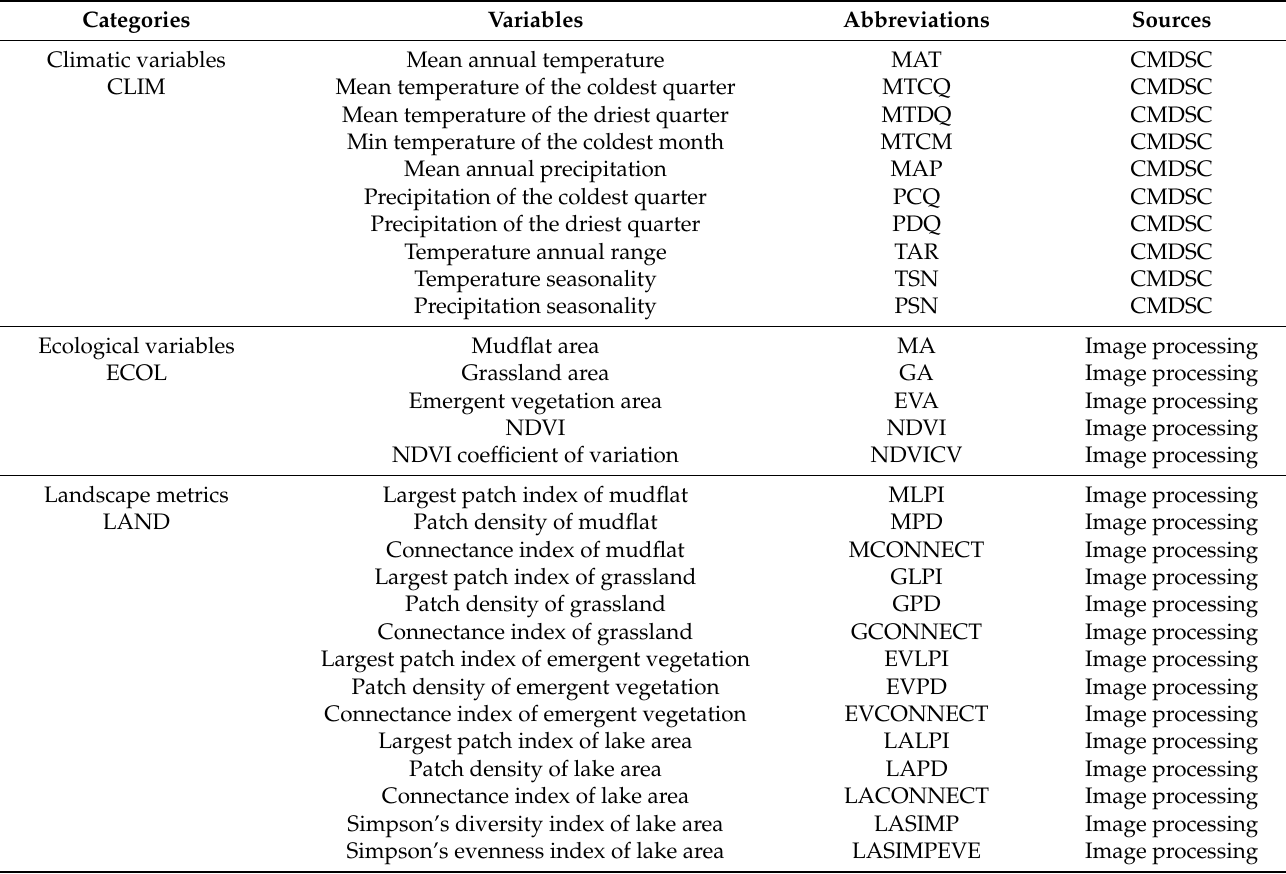
Table 1. Potential explanatory variables, their descriptions and abbreviations, and data sources used in this study. CMDSC: the China Meteorological Data Service